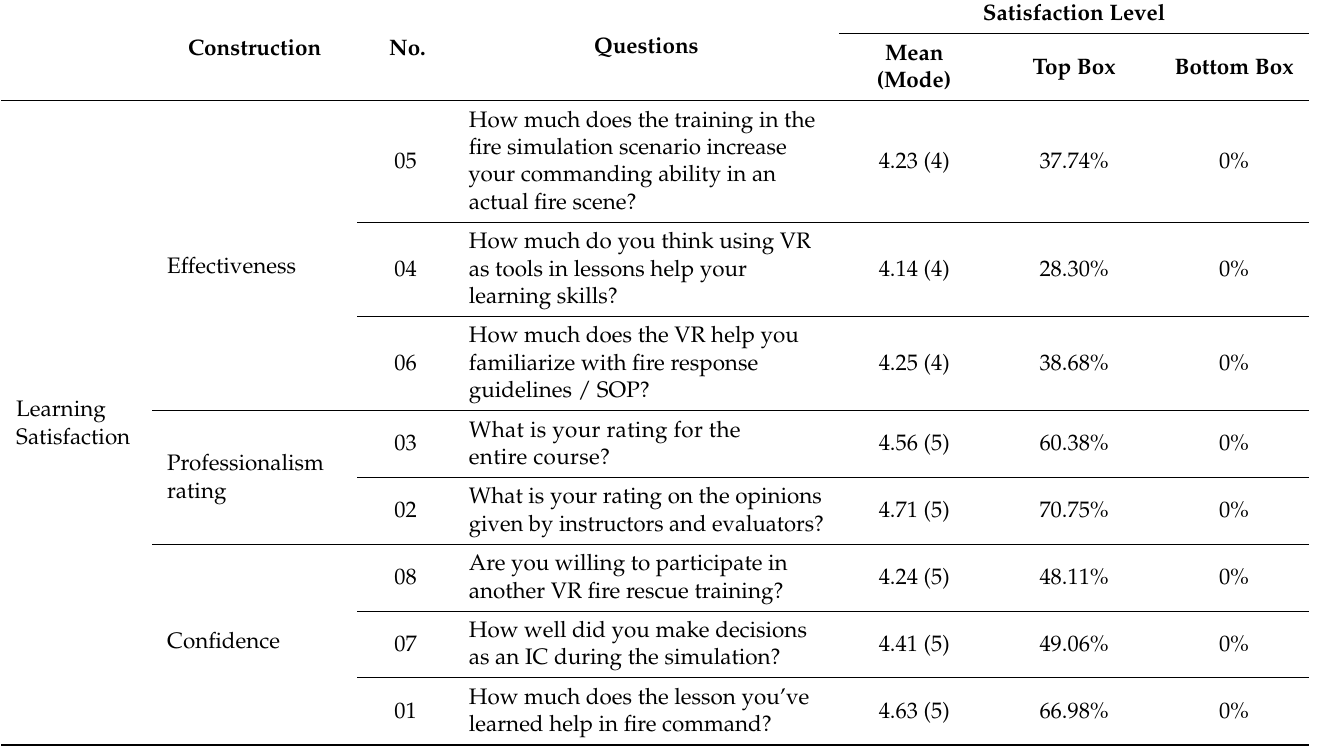
Table 9. Summary of this study’s satisfaction survey